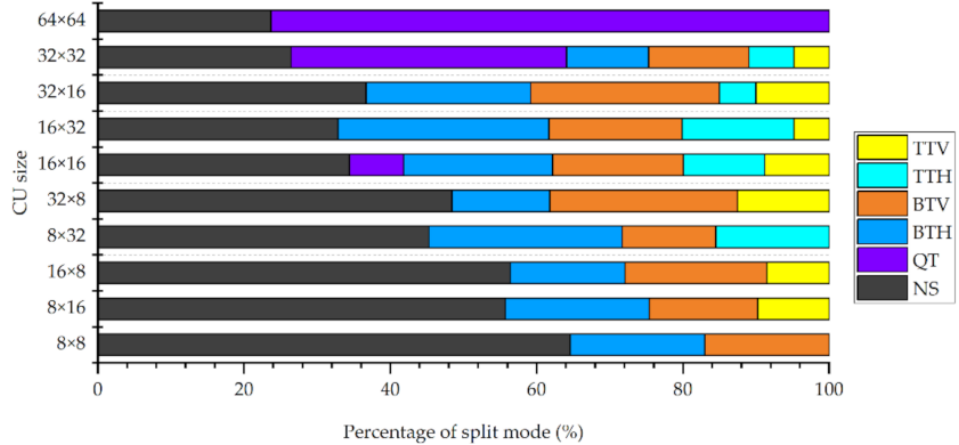
Figure 2. The proportion of the partition mode of CUs with different